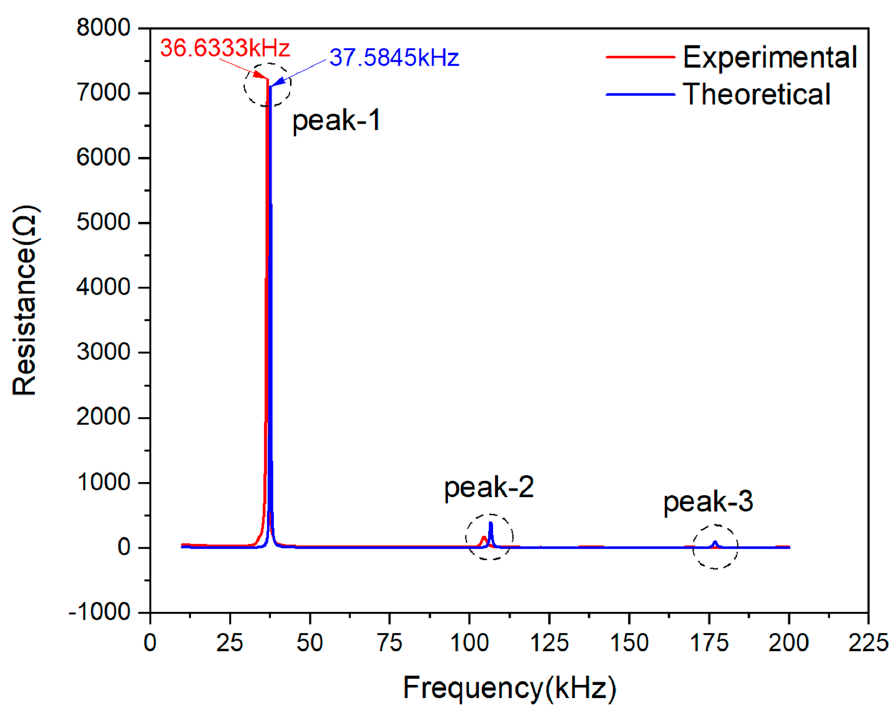
Figure 5. Experimental and theoretical resistance plots comparison of PZT#1.